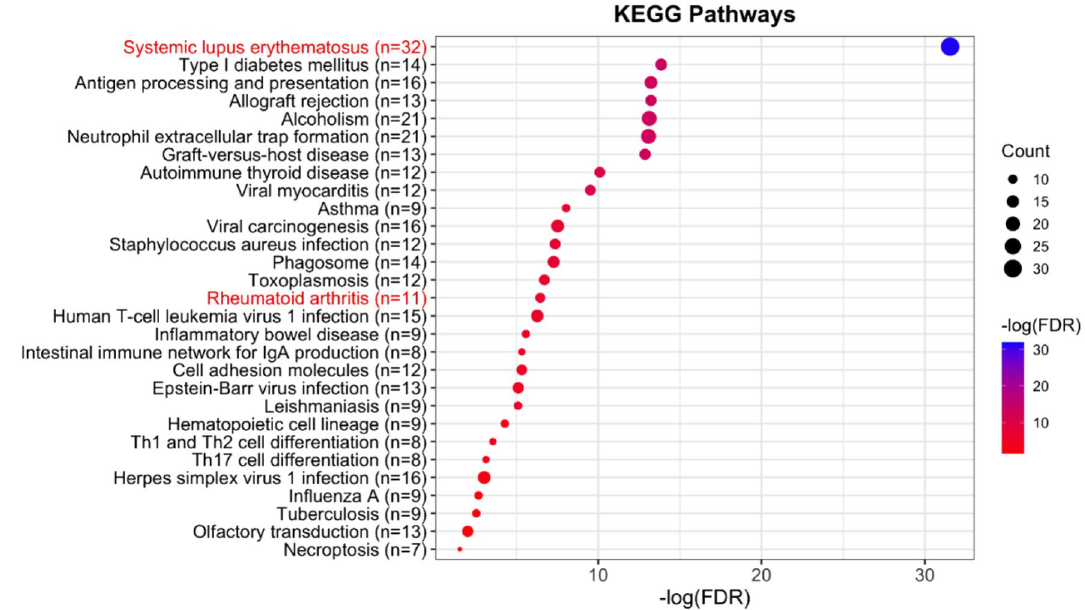
Figure 4. The KEGG pathway enrichment analysis is based on the genes identified by sCLC and the KEGG database. The pathways in red denote the pathways that are related to the diseases of the musculoskeletal system and connective